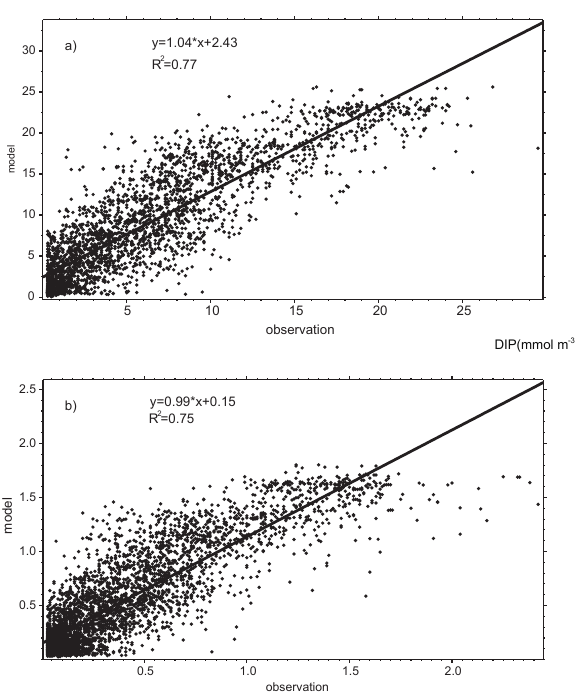
Fig. 8. Scatter plot of all the available (a) DIN and (b) DIP data Fig.8 from routine JMA observations around the shelf break (see Fig. 1 for position of stations) and corresponding model results at the same places in the same month and same day as the